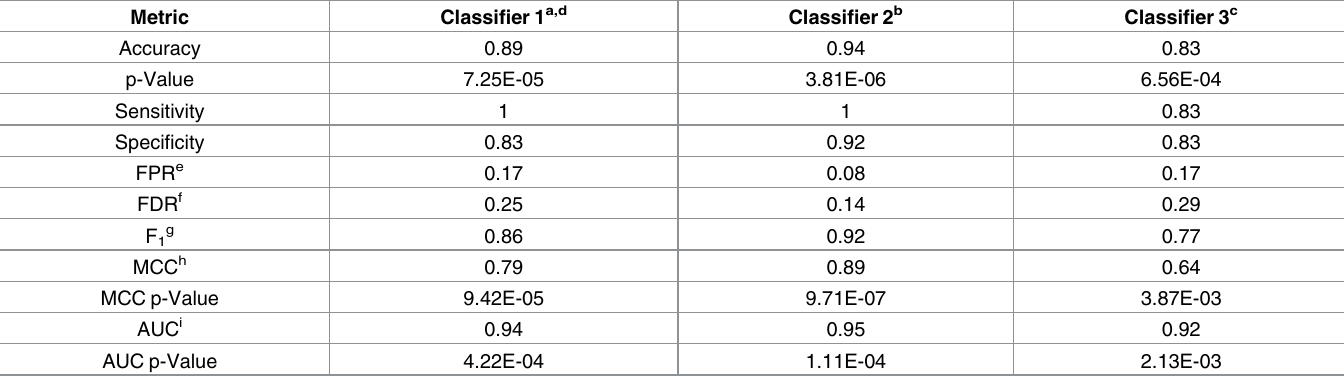
Table 2. ALS classifier accuracies with 6 Huntington’s disease samples included in test